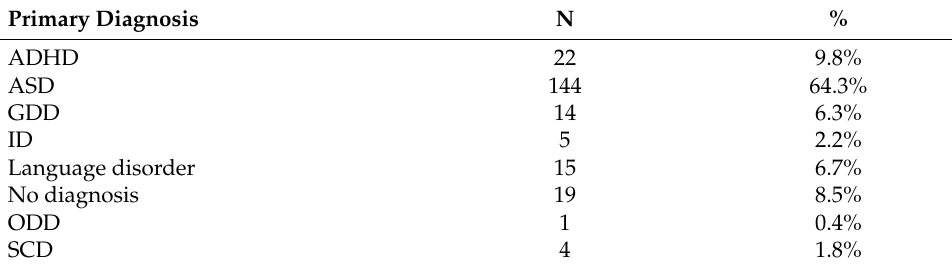
Table 3. Diagnosis after diagnostic